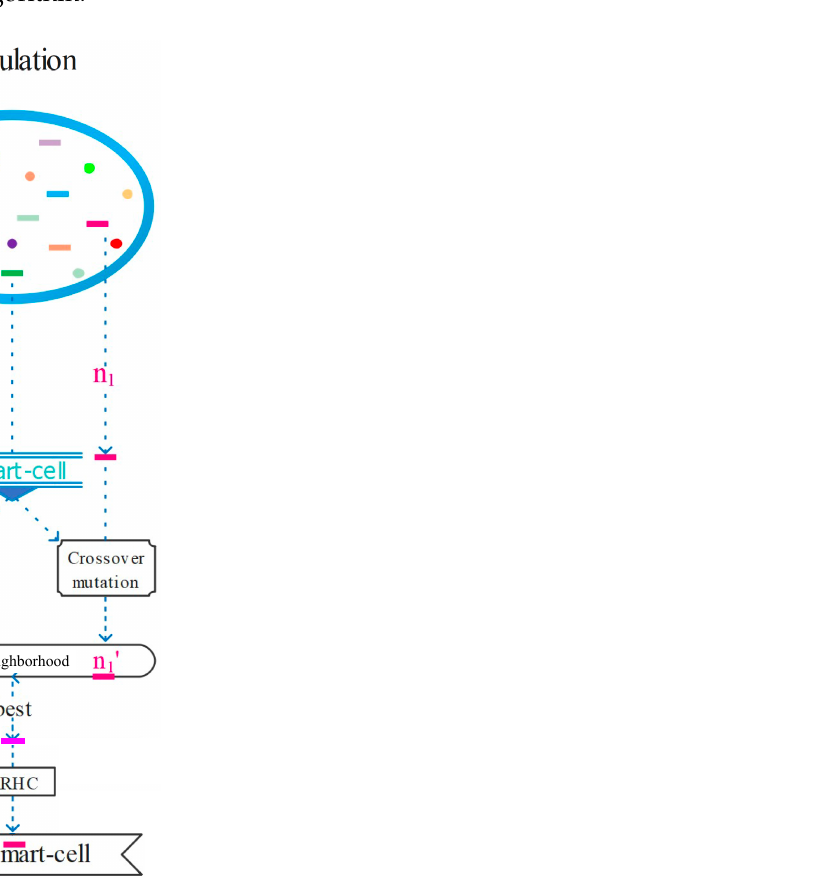
Figure 9. CA-type neighborhood used in the GA-RRHC. Colors represent the selection and modifica- tion of different